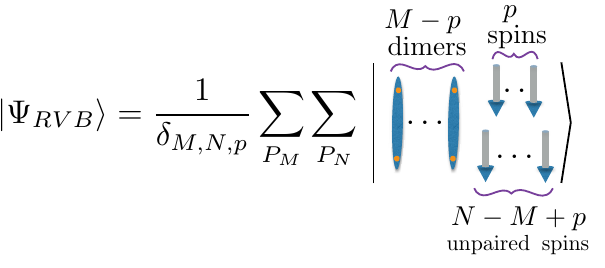
denotes a sum over all M de- N